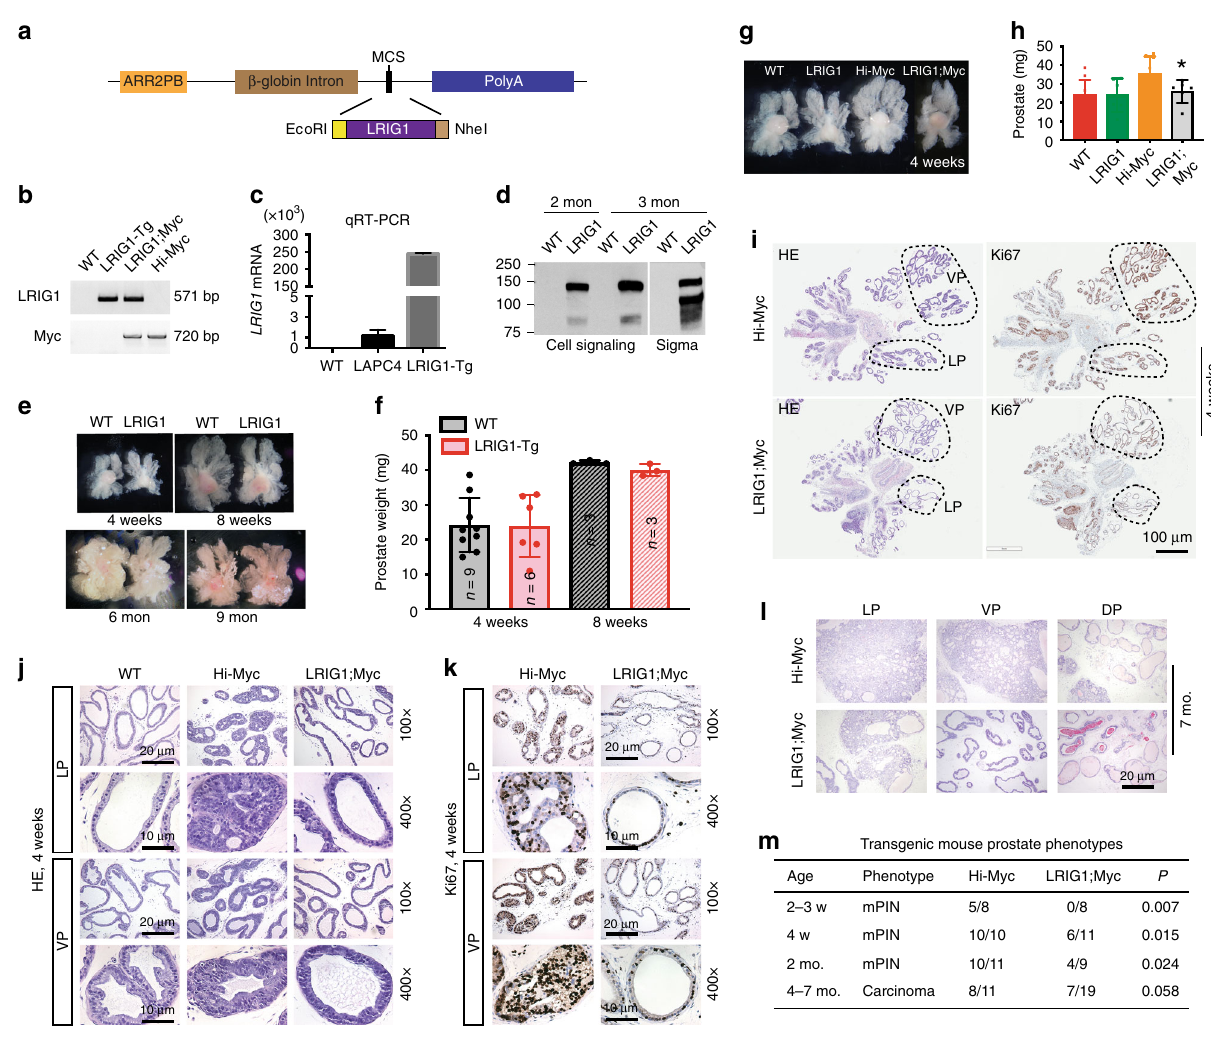
Fig. 4 Transgenic expression of LRIG1 inhibits Myc-driven tumorigenesis. a Schematic of the ARR2PB -LRIG1 construct. Human LRIG1 cDNA (3,282 bp) was cloned into EcoRI/NheI sites of pPB197 vector. b PCR genotyping of transgenes LRIG1 (top) or c-Myc (below) using genomic DNA from mouse tails. c qPCR analysis of human LRIG1 mRNA in prostates from both WT and LRIG1-Tg mice. LAPC4 cell RNA was used as a positive control. Results are representative of three experiments. d WB of human LRIG1 protein expression in the prostates of 2- or 3-month-old animals using two different human- speci fi c LRIG1 antibodies. Note that Sigma mAb detected two bands at 143 kDa and ~110 kDa whereas Cell Signaling pAb detected mainly the 143 kDa band. e Representative whole-mount images of the prostates from WT and LRIG1-Tg mice at 4 and 8 weeks, and 6 and 9 months ( n = 3 – 9 for various age groups). f Prostate weights of WT and LRIG1-Tg mice at 4 and 8 weeks (the number of animals analyzed are indicated in the bars). Note that at 8 weeks, the LRIG1-Tg prostates were slightly smaller than WT prostates ( P = 0.0127; Student ’ s t -test). g , h The LRIG1;Myc prostate is smaller than Hi-Myc prostate. Shown are representative images of microdissected prostates ( g ) and average weight of prostate lobes ( h ) from the indicated genotypes at 4 weeks old (bars represent mean ± S.D and n = 9, 6, 8, and 6 for the four genotypes). In h , the P -value (* P < 0.05) was determined by Student ’ s t -test. i Aperio Scanscope images of HE (left) and Ki67 (right) stained sections of a pair of Hi-Myc and LRIG1;Myc prostates. Scale bar, 100 μ m. j , k Representative HE ( h ) and Ki67 ( i ) images (original magni fi cations and scale bars indicated) in the LP and VP sections of indicated genotypes. l Representative HE images of prostates lobes in 7-month-old Hi-Myc and dTg mice. Scale bar, 20 μ m. m Summary of prostate pathologies in the indicated genetic mouse models. Differences in incidence between the Hi-Myc and LRIG1;Myc phenotypes were analyzed by χ 2 test. *Source data for Fig. 4c, d, f, h are provided as a Source Data fi